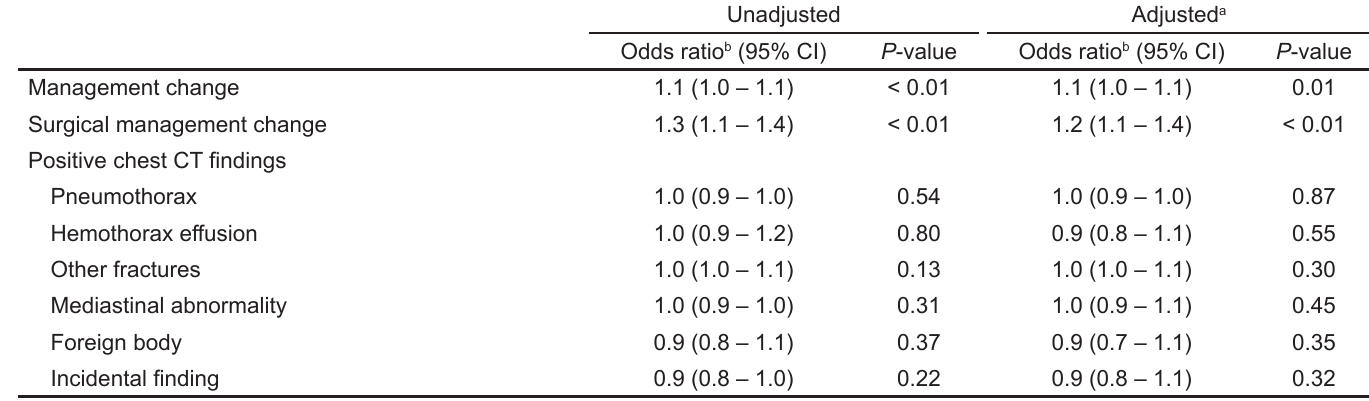
a The adjusted odds ratios were adjusted for injury mechanism (fall, motor vehicle collision, and other), Injury Severity Score, Glasgow Coma Scale, hypotension, and tachycardia. b Odds ratio for each additional year of age. CT , computed tomography; CI , confidence interval.